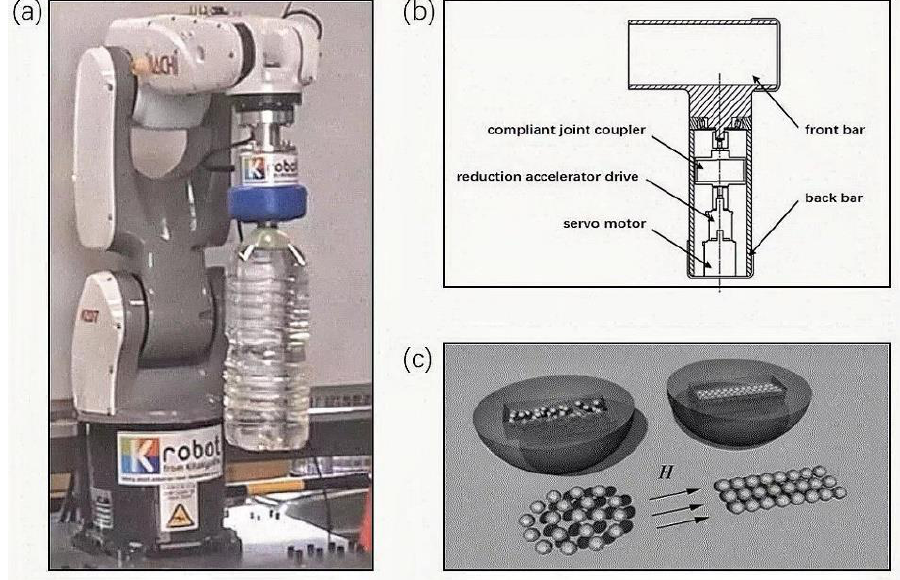
Figure 6. ( a ) Operation of the developed gripper using the MRα fluid [63] . ( b ) A robot flex joint [64]. ( c ) Design scheme of a spherical magnetic robot [65].